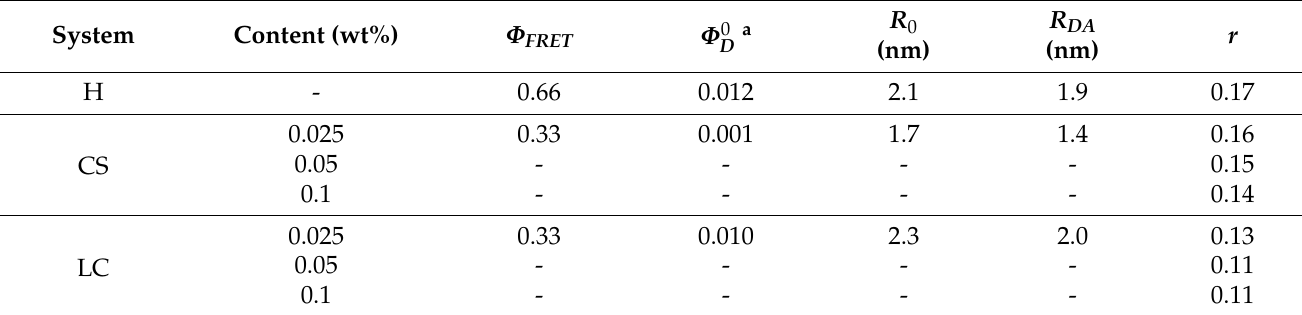
Table 1. Förster Resonance Energy Transfer (FRET) efficiencies ( Φ FRET ), fluorescence quantum yields of the donor (hydrogel aggregates) ( Φ 0 ), donor-acceptor distances ( R DA ) and steady-state fluorescence anisotropy ( r ) values for gels with an D incorporated drug. Anisotropy value of doxorubicin in glycerol (at 25 ◦ C): r = 0.285.